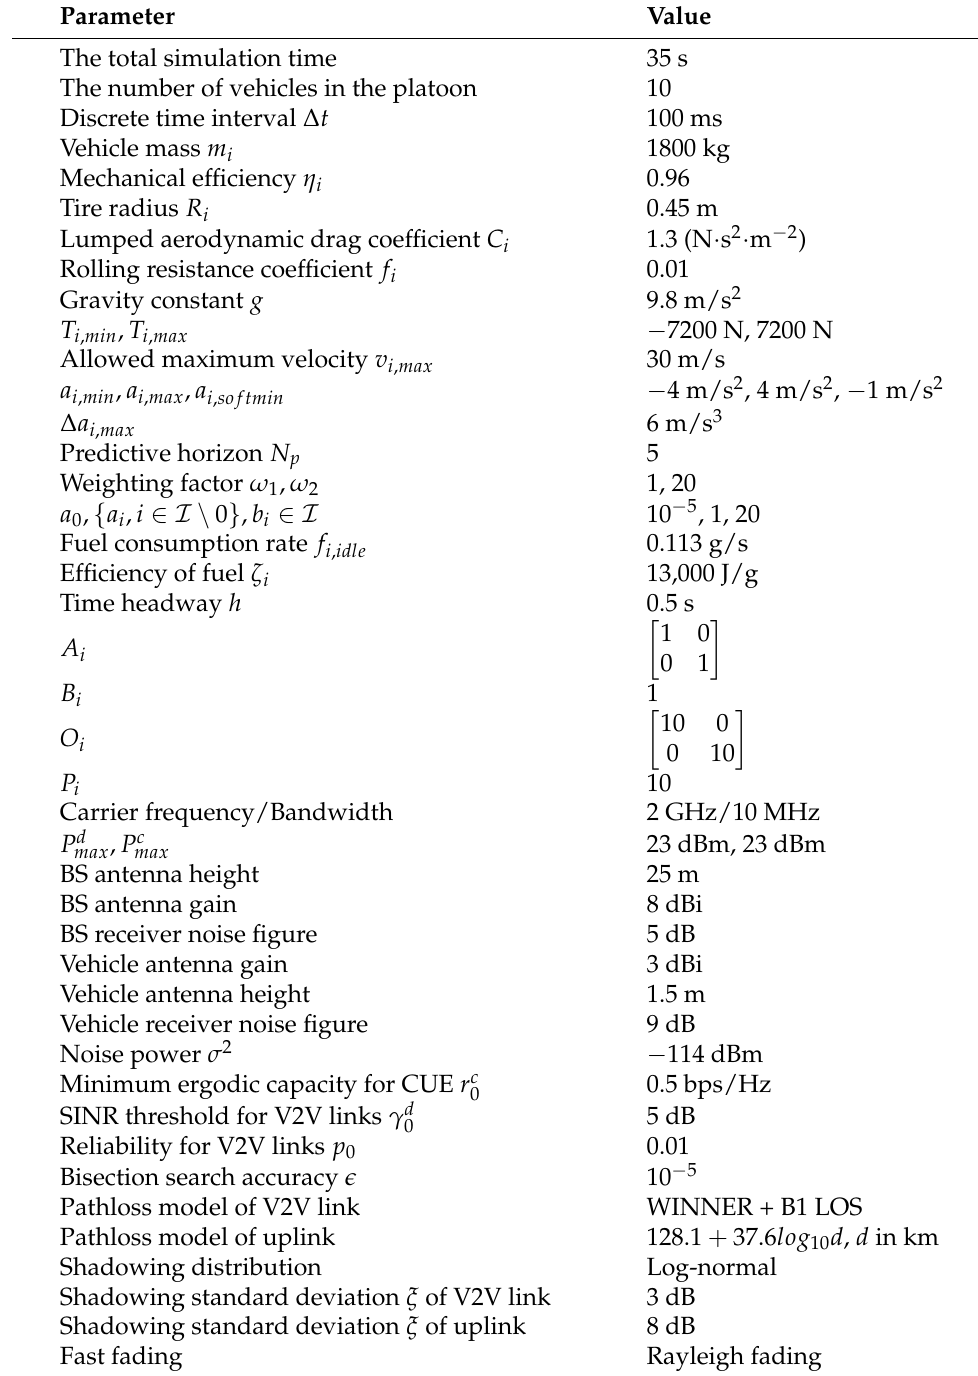
Table 1. Vehicle dynamic and wireless channel simulation